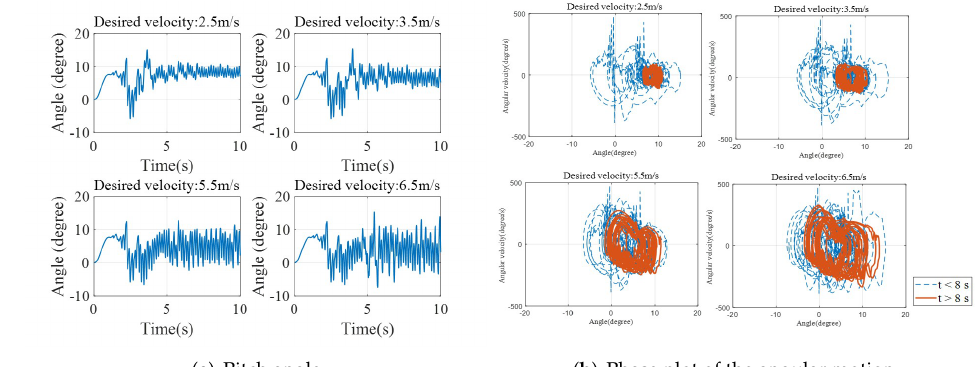
Figure 10. Angular motion of the upper body.